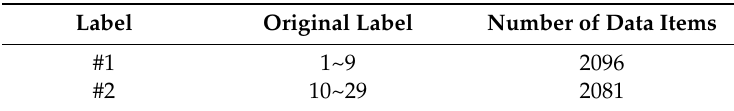
Table 1. Abalone dataset.